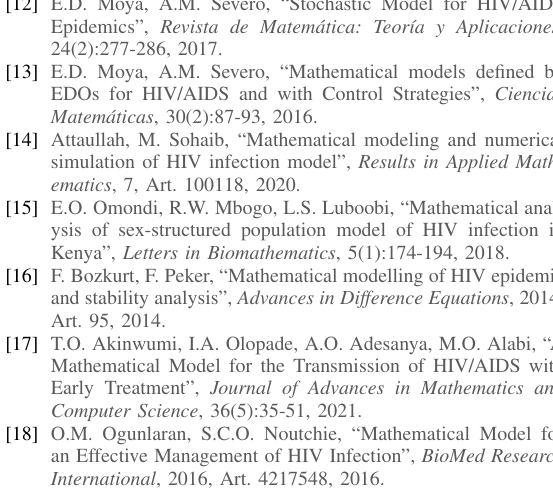
(c) AIDS men for different scenarios. (d) AIDS women for different scenarios. Fig. 15: Behavior of HIV and AIDS for joint variation of undetectability parameters for HIV and